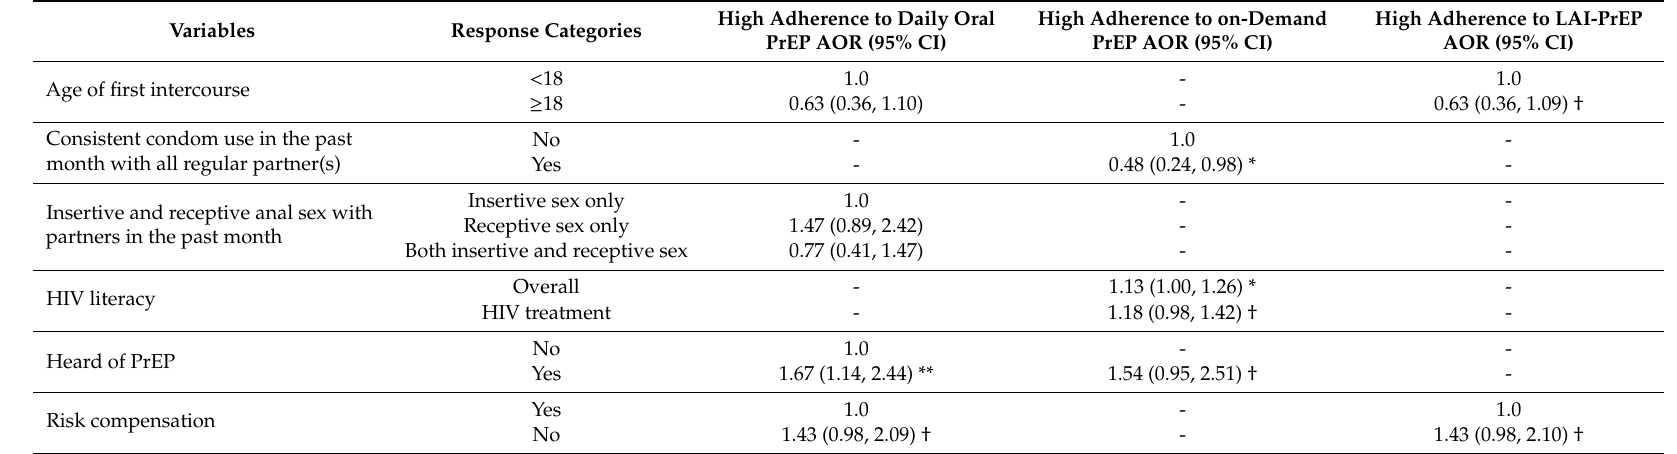
Table 5. Multivariate analysis of association between variables and adherence to